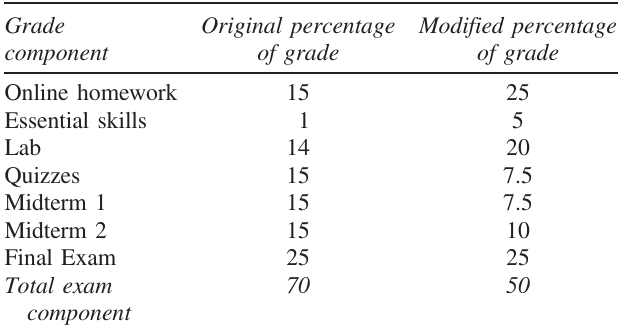
TABLE VI. Original percentage of grade components used to calculate the grades students received vs modified percentage of grade components used as a comparison